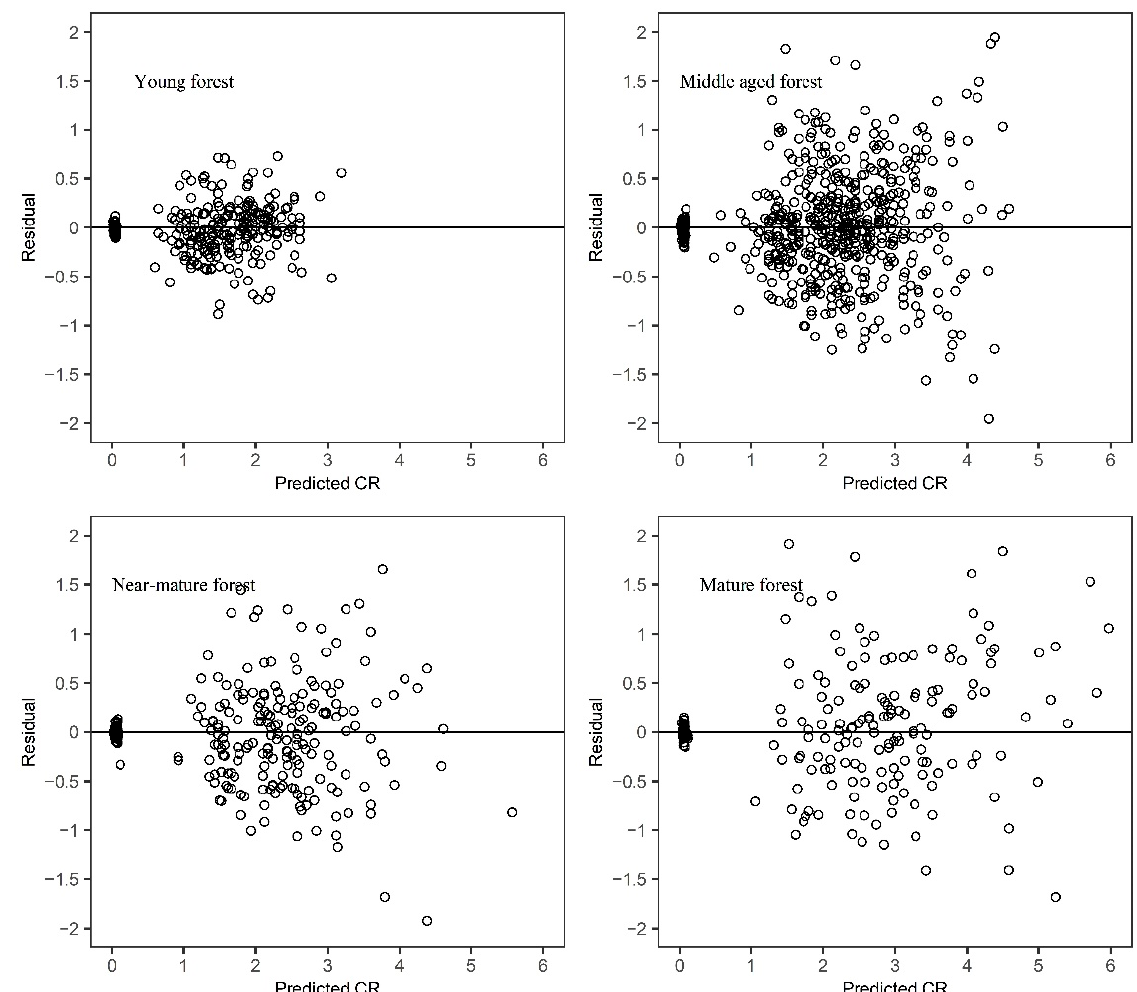
Figure 5. CR residuals plotted against predicted values for the optimal crown profile model of Chi- nese fir trees in four age groups (young forest: ≤ 10 years, middle aged forest: 11–20 years, near- mature forest: 21–25 years, mature forest:26–35 years).